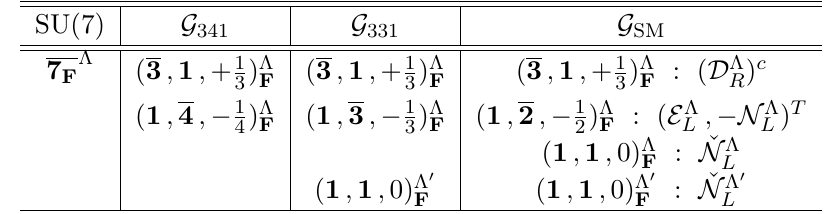
) c = ( d Λ ) c for R R ) c = ( D Λ ) c for the heavy right-handed R R